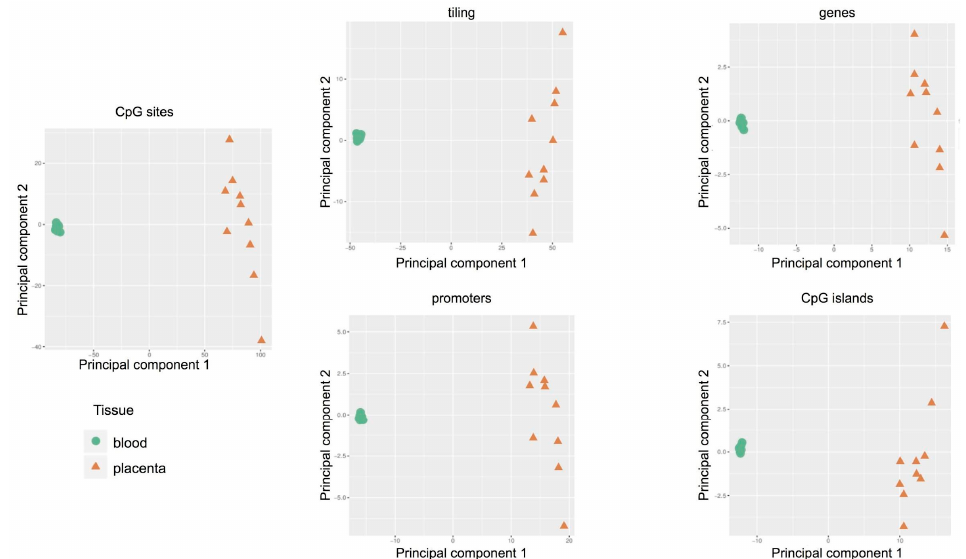
Figure 3. Methylation-profiling microarray: Principal Component Analysis (PCA) in 10 pregnancies (cases 1–10). Scatter plot showing the samples coordinates on principal components based on methylation scores of CpG sites and regions: tiling, genes, promoters, and CpG islands.